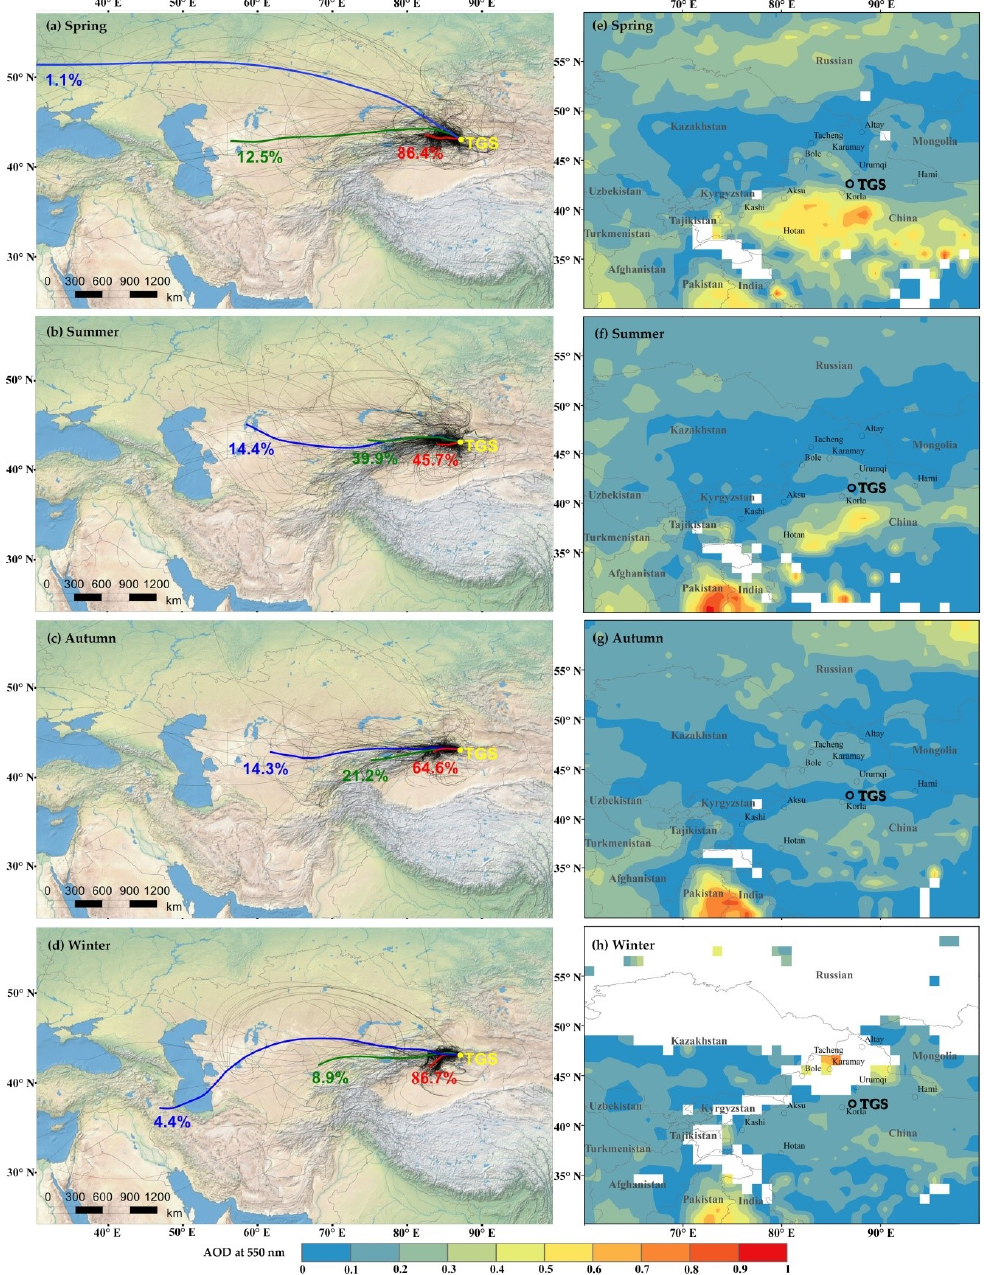
Figure 10. The 5-day backward air-mass trajectories calculated by the HYSPLIT model ending at TGS including the percentages of each cluster trajectories in: ( a ) spring, ( b ) summer, ( c ) autumn, ( d ) winter, and area-averaged maps of aerosol optical depths (AOD) including TGS site and its surroundings in: ( e ) spring, ( f ) summer, ( g ) autumn, ( h ) winter.